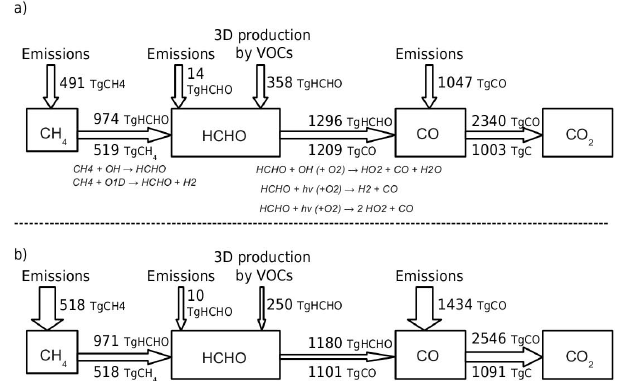
Fig. 1. Prior (a) and posterior (b) HCHO sources and sinks in the SACS mechanism. Sinks of H 2 and the HCHO deposition are in- cluded in SACS but not displayed. Changes of arrow thickness be- tween prior and posterior indicate a reduction or an increase of the sources and sinks. Values are for year